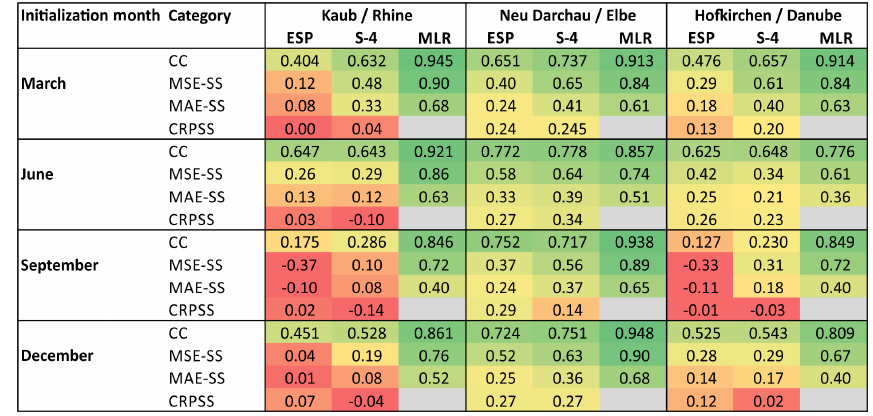
Figure 8. Comparison of forecast skill of ESP, ECMWF-driven and statistical forecasts at the stations Kaub, Neu Darchau, Hofkirchen predicting mean flow of the next 3 months 3MoMQ initialized in March, June, September and December (verification period